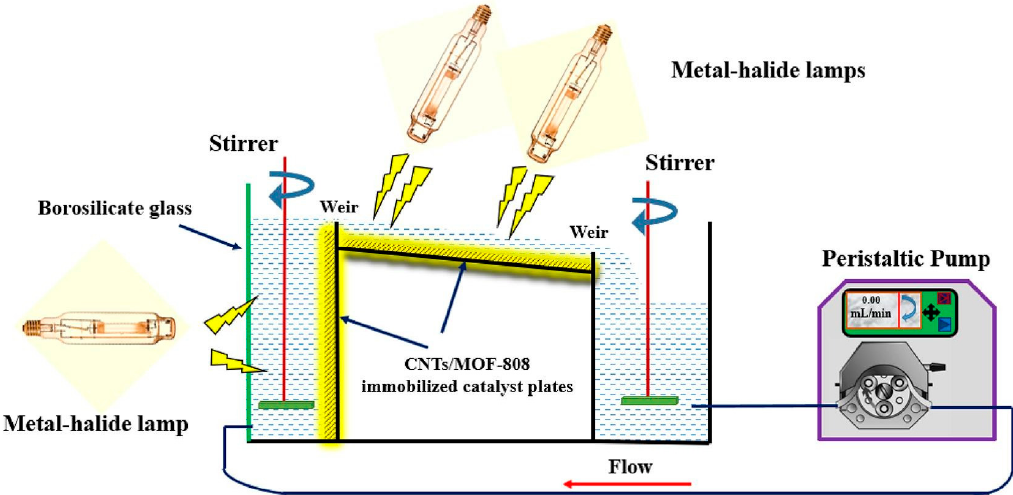
Figure 5. Novel photocatalytic reactor with CNTs/MOF-808 painted plates [119]. Jiménez-Tototzintle et al. treated real agricultural wastewater in an Immobilized Bi-